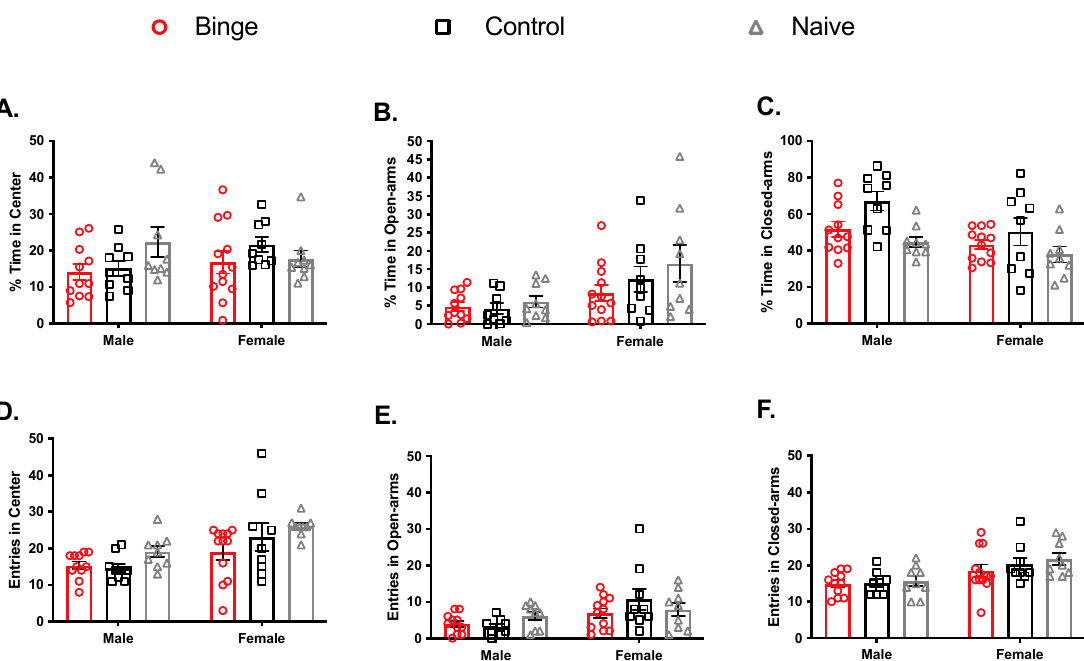
Figure 3. Effect of multiple binge on locomotor activity and behavioral despair in young adult rats. OF data was collected and analyzed from automatic tracking software in the first five minutes. ( A ) There was a main effect of sex, with females traveling further than males. ( B ) Time spent in the center of the OF did not differ by sex or binge exposure. ( C ) In the forced swim test, binged animals showed more immobility time than controls. Bars represent ± SEM from 9–12 subjects per group.